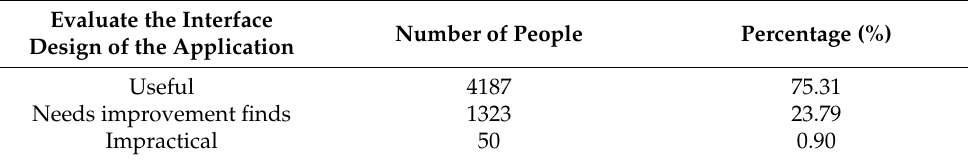
Table 6. User interface satisfaction survey results.